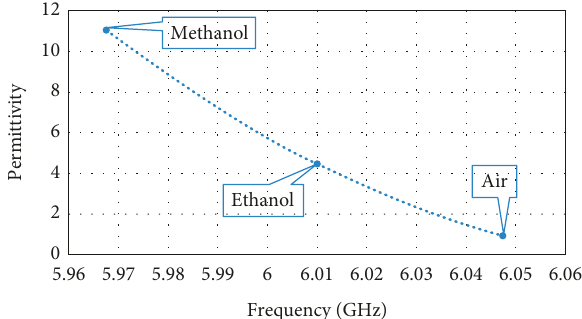
Figure 9: Measured polynomial fitting curve of the permittivity.